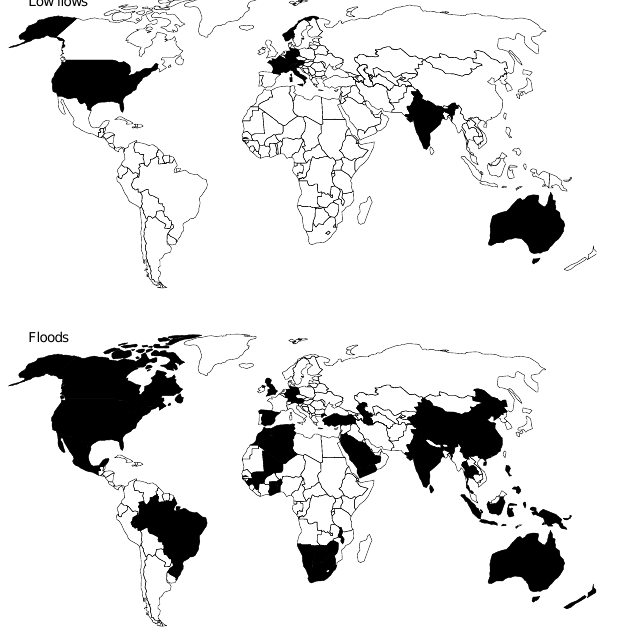
Fig. 1. Map indicating the countries included in the meta-analysis of low flow studies (top) and flood studies (down) reported in the literature (Level 1 assessment).